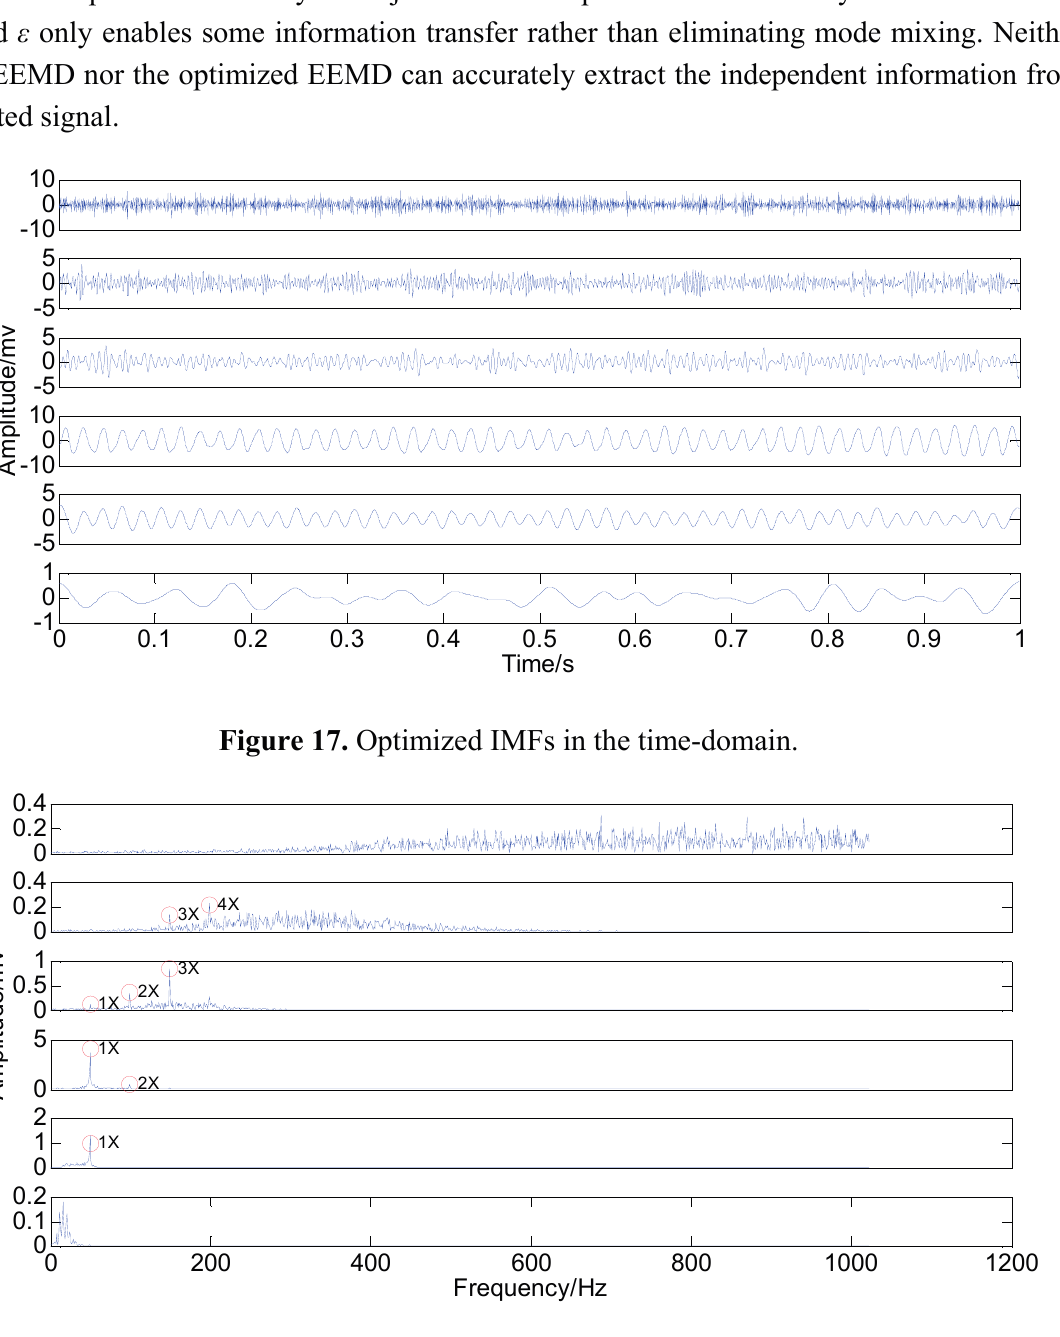
Figure 18. Optimized IMFs in the